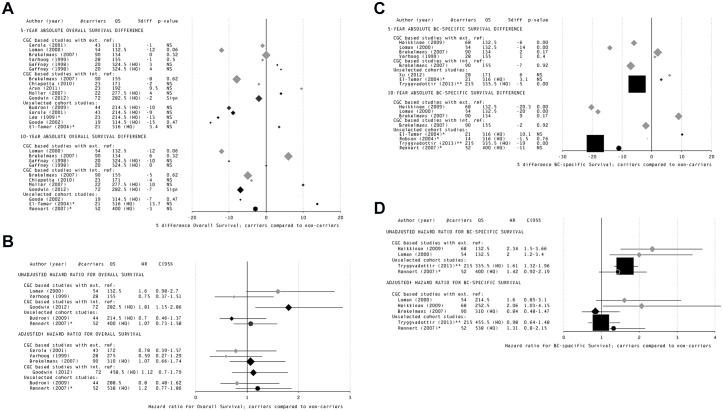
Forest plots of studies reporting survival estimates for BRCA2 mutation carriers compared to ‘non-carriers’, classified per study type and sorted by quality score.Separate forest plots are shown of studies reporting overall survival (panels A and B), breast cancer-specific survival (panels C and D) of BRCA2 mutation carriers compared to ‘non-carriers’. Additionally, the results for each type of survival outcome are stratified per reported risk estimate: the 5-year and 10-year absolute overall survival difference (panels A and C) and the adjusted and unadjusted hazard ratios for overall survival (panels B and D). Size of the bullet represents the number of included carriers; black bullet = HQ study; round bullet (●) and * = A. Jewish study population, only founder mutations tested; square bullet (■) and ** = specific study population (but not A. Jewish), in which only founder mutations were tested; — = 95% Confidence interval (only for hazard ratios); CGC based studies with ext. ref. = CGC based studies with external reference group; CGC based studies with int. ref. = CGC based studies with internal reference group; Sign = statistically significant (P < 0.05); NS = not statistically significant; NR = not reported; †Adjusted for clinico-pathological characteristics and/or treatment.